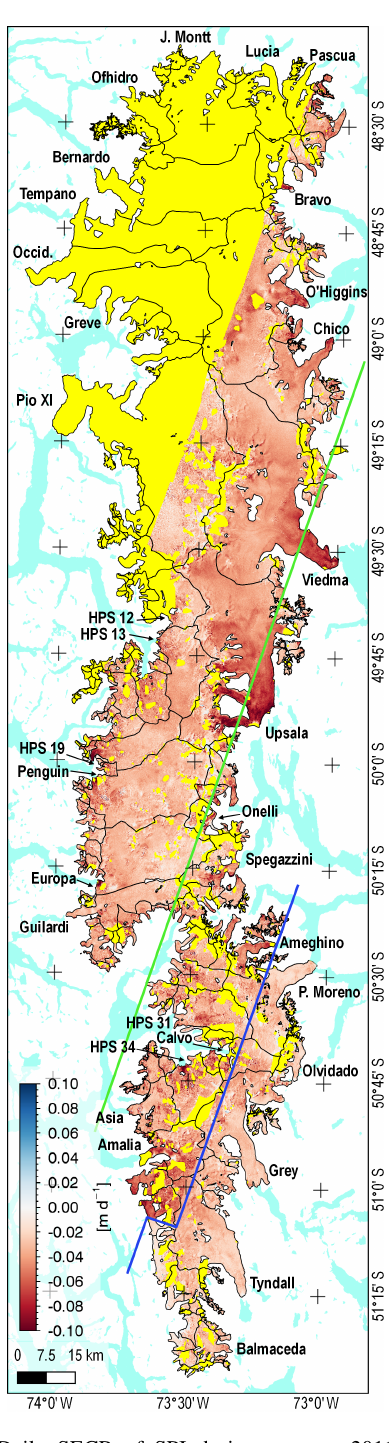
Figure 8. Daily SECR of SPI during summer 2011/2012. Ac- quisition dates north of the green line: 18 December–26 March (time span: 99d); between the green and blue lines: 7 December– 15 March (99d); south of the blue line: 29 December–31 January (33d). Unsurveyed areas are marked in yellow (including regions of high backscattering which were masked out). The SECR was fur- ther filtered with a median and a smoothing filter of kernel size